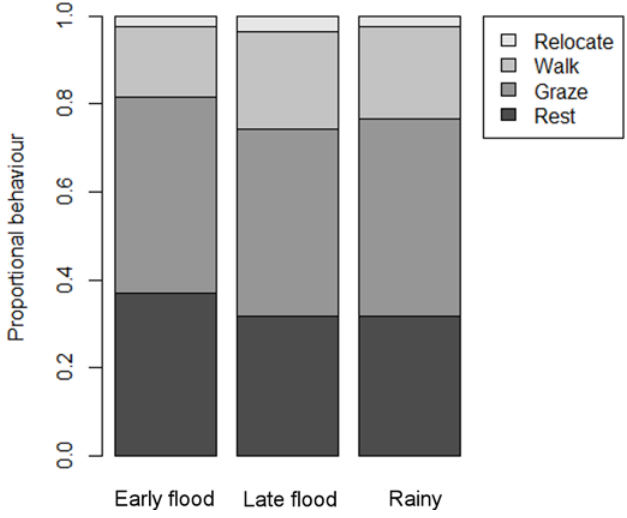
Fig 2. Seasonal variation in behaviour of 14, 15 and 15 female buffalo,